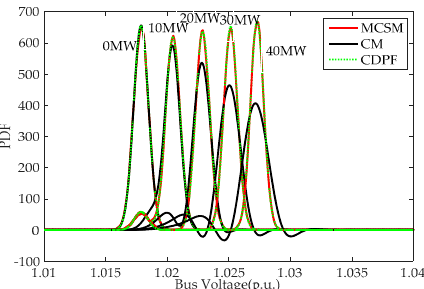
Figure 6. The PDFs of the voltage magnitude at bus-14 with the rated power of FCG at bus-14 being